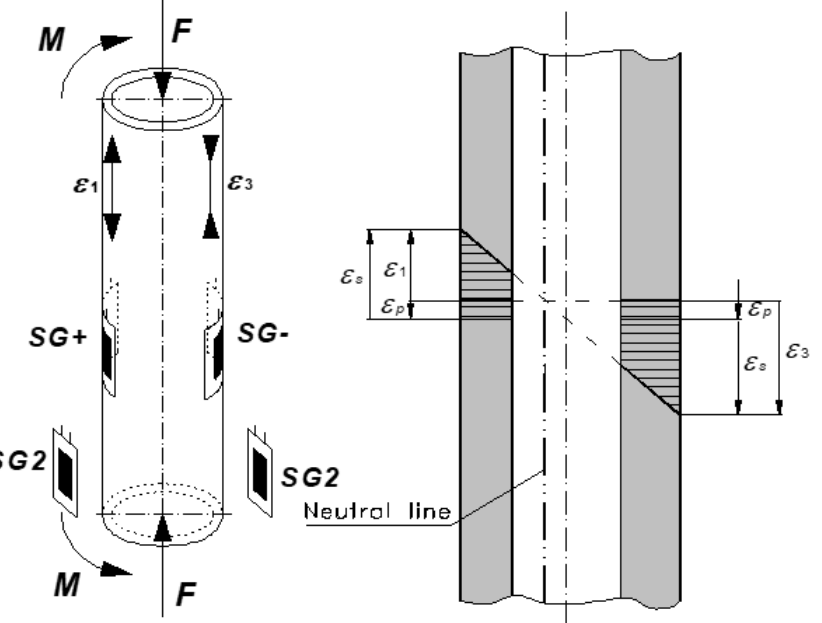
Figure 8. Placement of strain gauges on fixator tree.